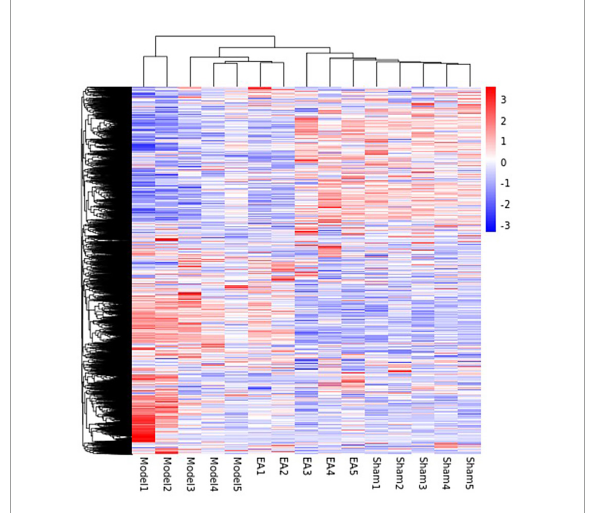
FIGURE4 Hierarchical cluster heat map of DEG in each group. This heat map can intuitively compare the homogeneity and differences between groups. Each column in the figure represents a sample, and each row represents a gene. The color in the figure represents the expression amount of the gene in the sample, red represents the high expression amount, and blue represents the low expression amount. The number label next to the color bar at the top left is the specific change trend of the expression amount. On the left is the dendrogram of gene clustering and the module diagram of sub clustering, the closer the two gene branches are, the closer their expression is. The upper part is the dendrogram of sample clustering, and the lower part is the name of the sample. The closer the two sample branches are, the closer the expression pattern of all genes in the two samples